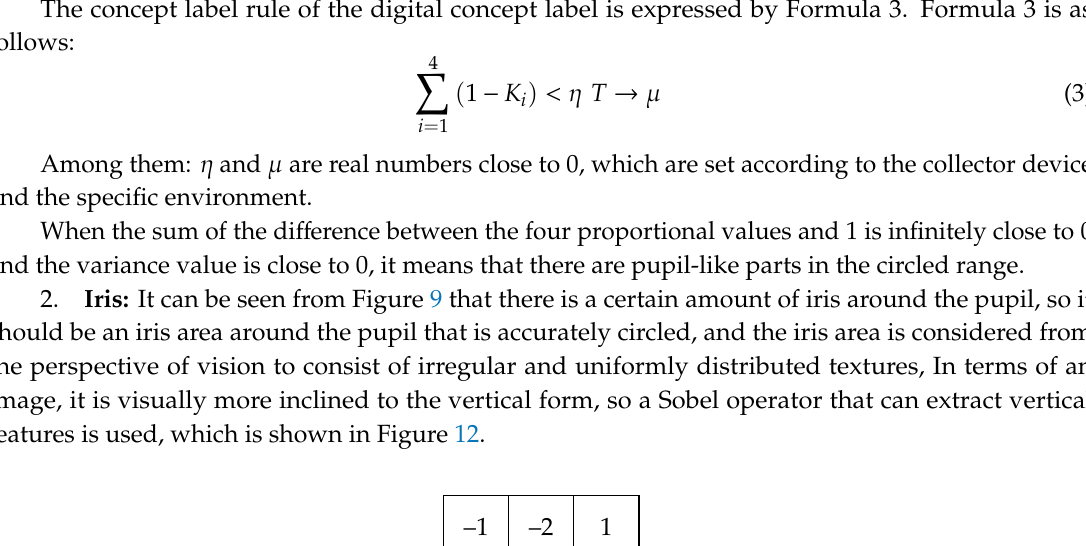
Figure 13. Example of salient images with and without an iris image. ( a ) Salient image of Figure 2b, ( b ) salient image of Figure 2d, ( c ) salient image of Figure 2f, ( d ) example of eyeless highlight image, ( e ) example of salient image with incorrect pupil delineation. It can be seen from Figure 13 that after the iris image is highlighted again, the points with a gray value of 255 are distributed throughout the highlighted image. Images with no eyes or no iris have fewer point distributions with a gray value of 255, which is used as a subjective concept for the iris. The process of turning subjective concepts into digital concepts is as follows: (1) In order to reduce the amount of calculations, the normalized image of the iris connected area image is intercepted, and the 512 × 64 dimension image is divided into eight 64 × 64 dimension images on average. The intercepted coordinate points of the image with the smallest gray value among the 8 images is recorded; (2) The outstanding image is equally divided into eight 64 × 64 dimensional images, and the image at the same position as the intercepted coordinate point recorded in 1) is selected as the iris detection image. The detection image of the iris part and the detection image of the non-iris part are shown in Figure 14. (a) ( b ) Figure 14. The detection image of the iris part and the detection image of the non-iris part. ( a ) Detection image of iris area, ( b ) detection image of non-iris area. (3) The minimum pooling method is used to minimize the detection image in 2 × 2 dimensions [27] to form a 32 × 32 dimensional pooling detection image. In order to better reflect the irregular and black-and-white form of the iris, the Hamming distance [28] is used for representation. Set the points with a gray value of 255 to 1 and the points with a gray value of 0 to 0 to form 32 binary sequences. Calculate the Hamming distance between each adjacent sequence, a total of 31 values, numbered 31 1 H H The 31 Hamming distances are the digital concept labels for this subjective concept. The concept label rule of the digital concept label is expressed by formula 4, which is as follows: